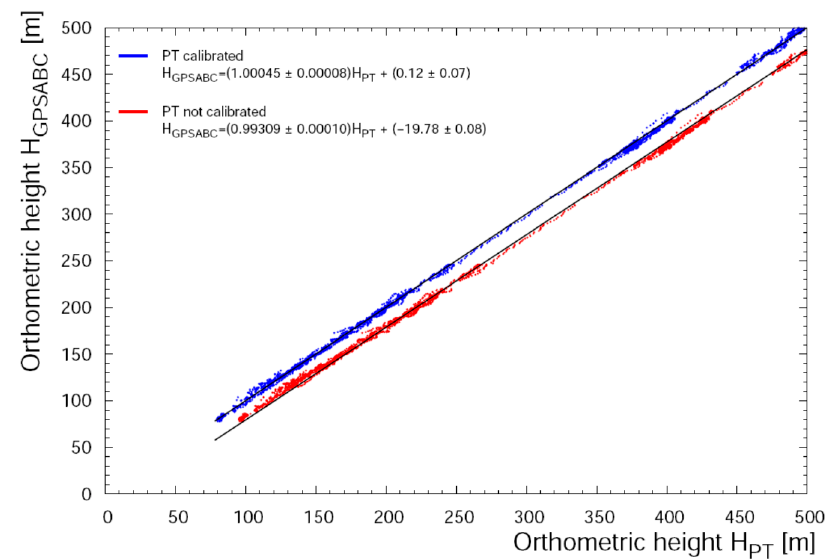
Figure 10. Linear regression between H GPSABC and H PT data for F11. In blue and red are reported the calibrated and not-calibrated barometric data respectively. The black straight lines are the linear fits to data: in both cases r 2 = 0.999.